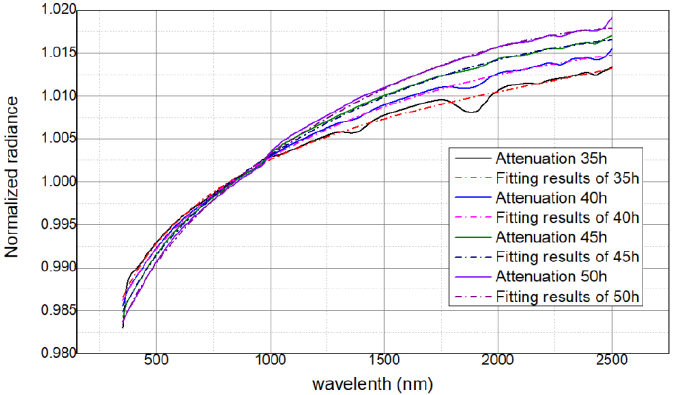
Figure 7. Spectral radiance attenuation of a tungsten halogen lamp.